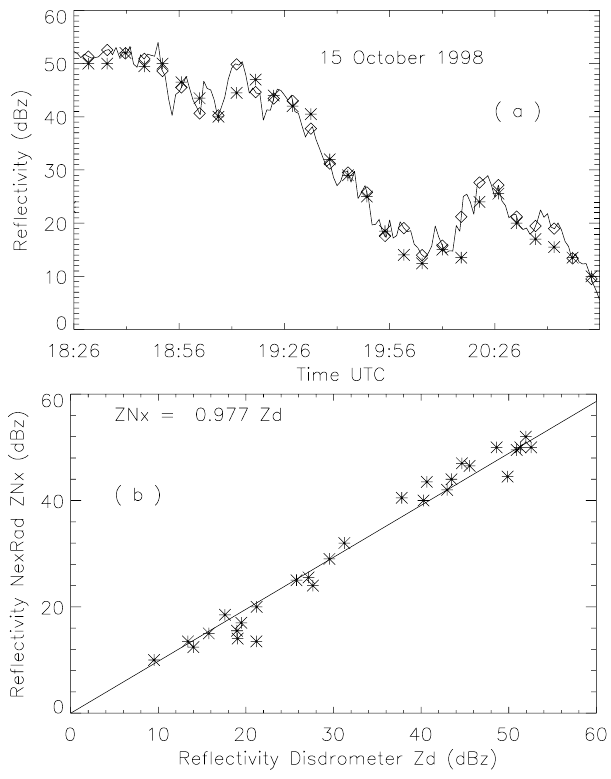
Fig. 5. (a) Time variation of the disdrometer and NexRad radar re- flectivities on 15 October 1998: Solid line and diamond: reflectivity computed by using drop size distribution measured by the disdrom- eter. Star: Reflectivity measured by the NexRad radar. (b) NexRad reflectivity as a function of the disdrometer